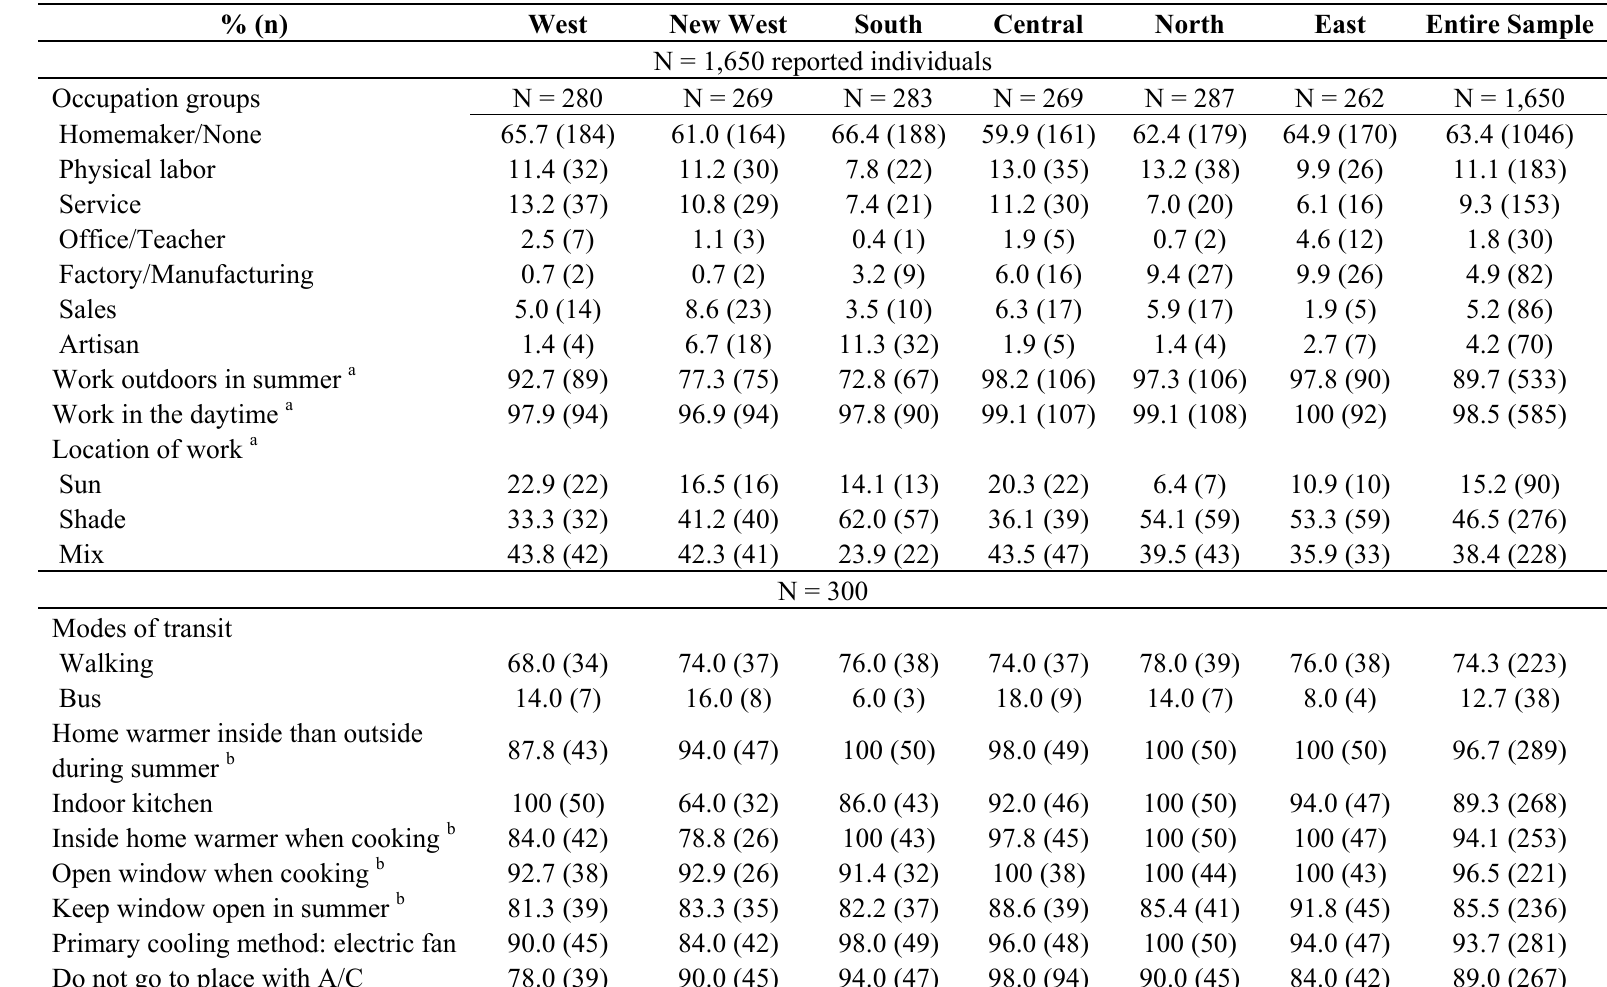
Table S1. Individual (N = 1,650) and household (N = 300) exposure factors among residents of Ahmedabad slums across six city